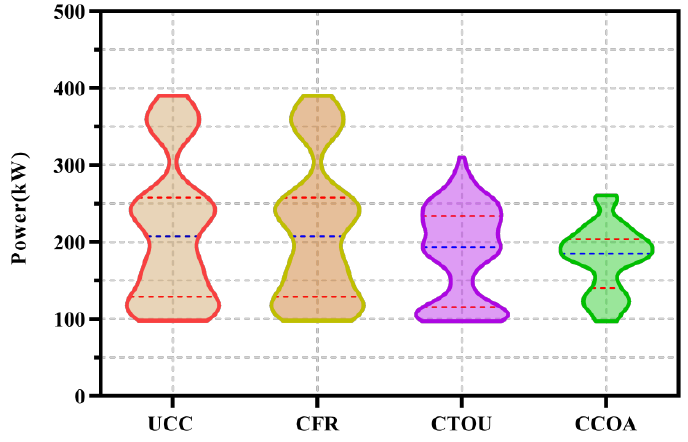
Figure 12. Violin graph of charging load profile concerning UCC, CFR, CTOU, and CCOA schemes.